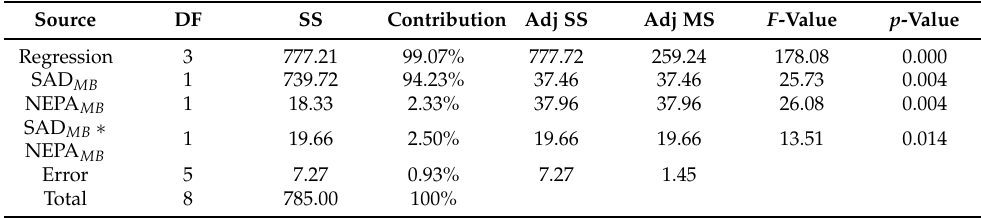
Table 4. ANOVA results for the Make breakfast PLSR